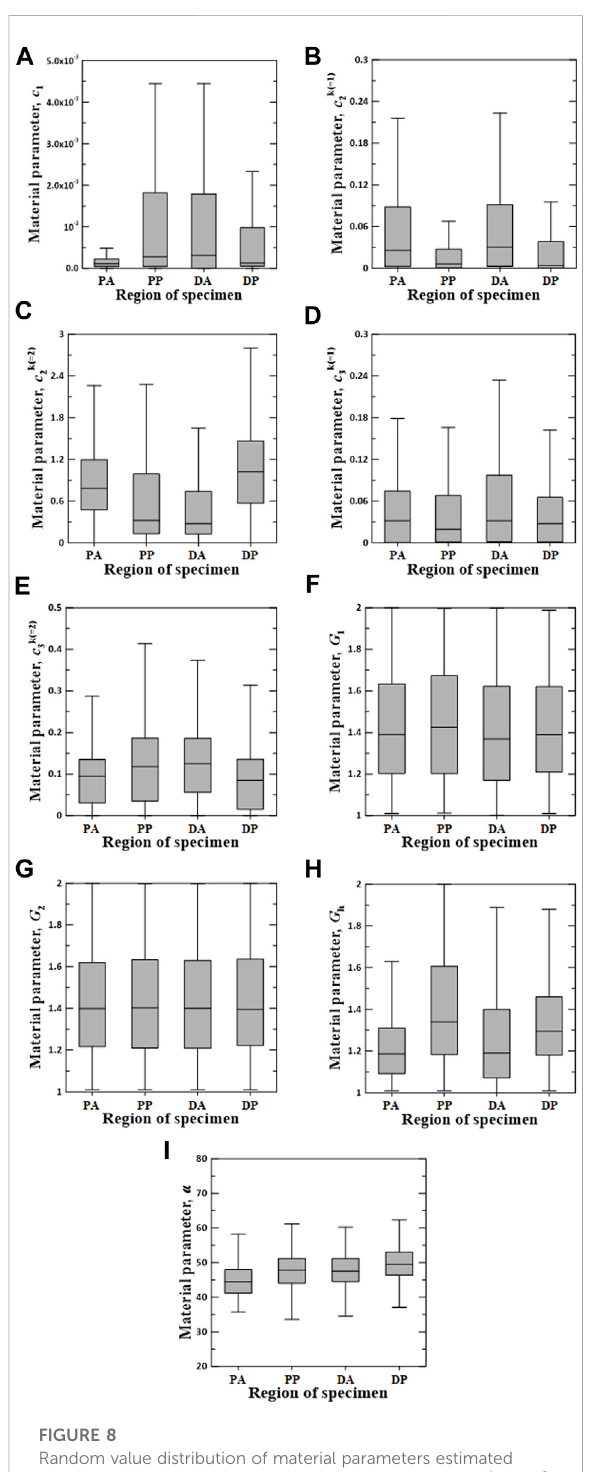
FIGURE 8 Random value distribution of material parameters estimated using CMM for PA, PP, DA, and DP specimens. (A) c 1 , (B) c 1 2 , (C) c 2 2 , (D) c